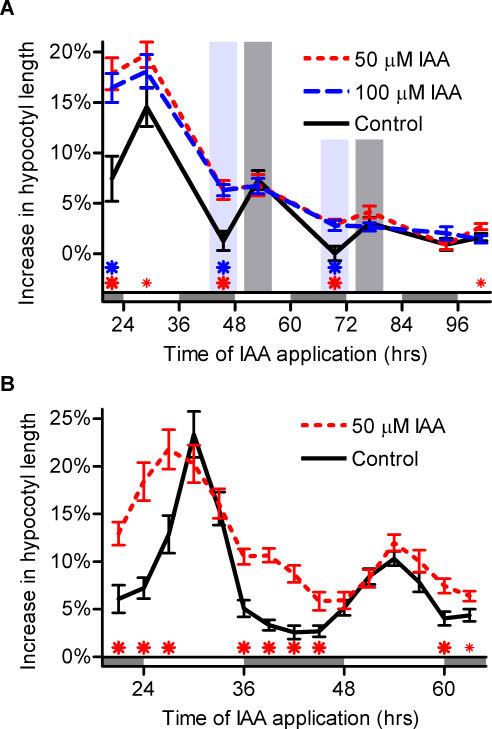
Auxin-Induced Hypocotyl Elongation Is Gated by the Circadian ClockHypocotyl elongation of free-running plants in response to auxin treatment was monitored twice a day for 4 d (A) or at 3-h intervals over 2 d (B). Plants were entrained for 3 d in 12-h white-light/12-h dark photoperiods and then transferred to constant red light. The time of auxin or mock treatment is graphed on the x-axis and the percent increase in hypocotyl length observed over the subsequent 6 h is indicated on the y-axis. Data points are plotted in the middle of each 6-h treatment. Asterisks on the x-axis indicate time points at which hypocotyl elongation of auxin-treated seedlings was significantly greater than in the controls (t-tests: small asterisk if p < 0.05, large asterisk if p < 0.01). (A) Areas shaded light- and dark-gray correspond to the 6-hr periods during which exogenous auxin promotes or has no effect, respectively, on hypocotyl elongation. (A) Shows representative data from two independent experiments. (See Figure S6 for a direct comparison of Figures 4C and [A]).